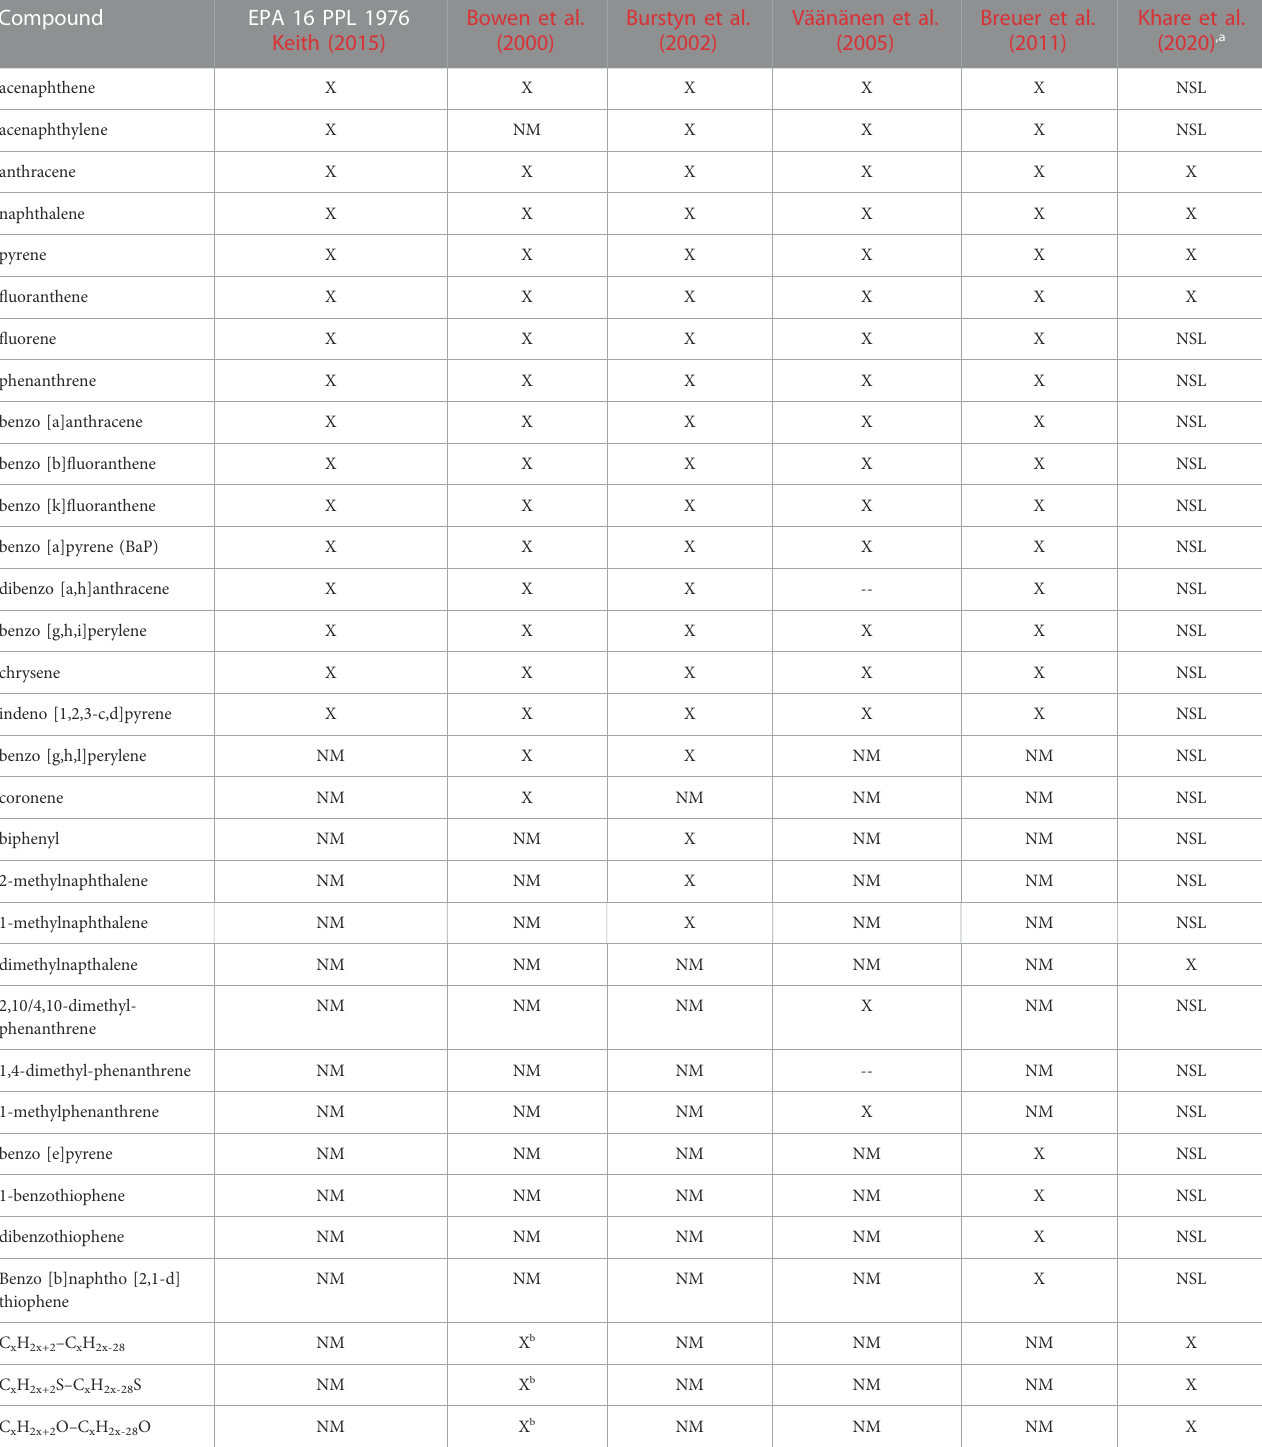
TABLE 1 Emissions from asphalt as measured in selected